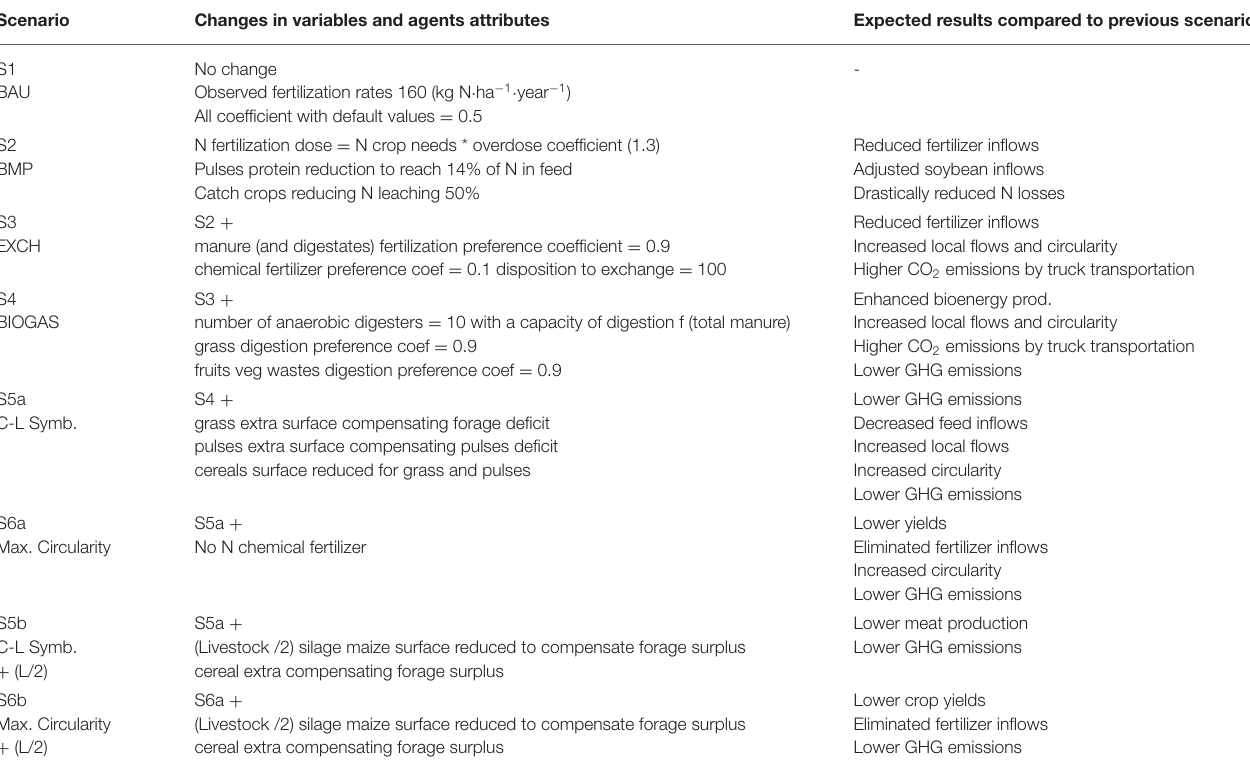
TABLE 2 | Specifications of scenarios in the FAN model and their expected results.